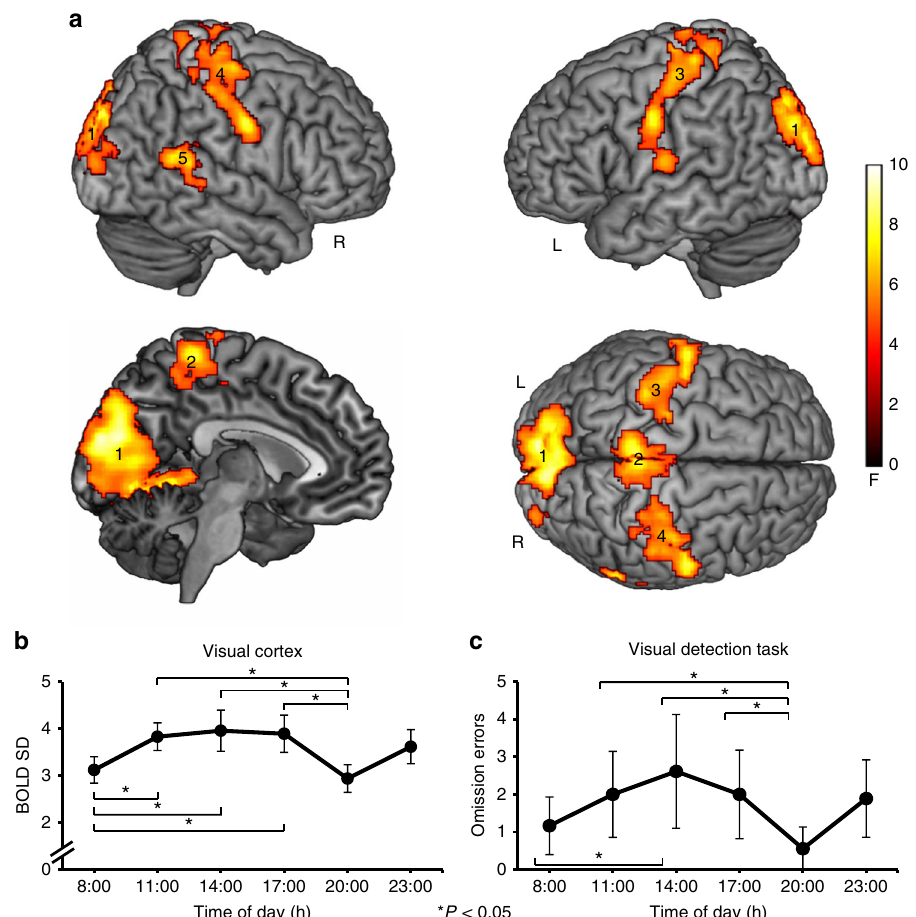
Fig. 1 Resting-state BOLD SD is reduced in sensory cortices at twilight, when visual detection is improved. a Signi fi cant main effect of ToD for resting-state BOLD SD in visual (cluster 1, peak MNI value − 8 − 90 20), somatosensory (clusters 2 – 4, peak MNI values − 4 − 38 68; − 60 − 8 40; 58 − 8 36), and right auditory cortices (cluster 5, peak MNI value 64 – 48 20) (cluster-extent based threshold: k = 395, P < 0.05, family-wise error (FWE) corrected; cluster- de fi ning primary threshold of F (5, 65) > 4.70, P < 0.001, uncorrected; n = 14). Color indicates F -values. For further statistical details see Table 1. b Group analysis showing signi fi cant resting-state BOLD SD decreases in visual cortex (cluster 1) at 08:00 and 20:00 h compared to midday measurements (graph shows the group-mean BOLD SD values and error bars represent the 95% con fi dence interval. Asterisks mark signi fi cant pairwise differences at P < 0.05, Bonferroni corrected). Note that somatosensory, and right auditory cortex show similar ToD-effects (Supplementary Fig. 1c). For further statistical details see Table 2. c Main effect of ToD for omission errors during the visual detection task. Participants committed signi fi cantly less omission errors at the same times, when resting-state BOLD SD was decreased (see b ; graph shows the group-mean omission errors and error bars represent the 95% con fi dence interval. Asterisks mark signi fi cant pairwise differences at P <